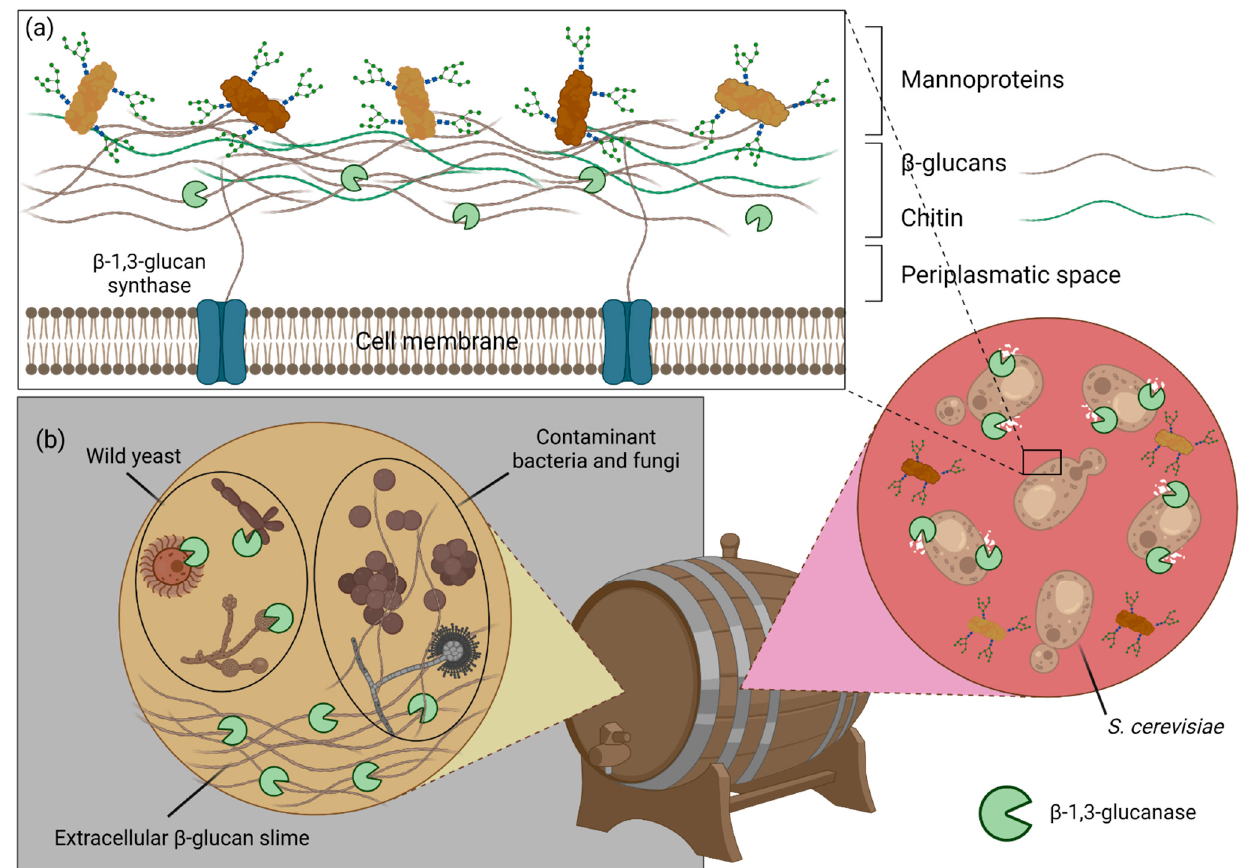
Figure 7. Applications of β -1,3-glucanases in the winemaking process. ( a ) The starter yeasts, usually S. cerevisiae , possess several components in their cell wall, most importantly mannoproteins that, when released into the wine, improve several organoleptic and technological properties of the final product. By hydrolyzing yeast cell wall β -glucans, β -1,3-glucanases promote the release of those mannoproteins. ( b ) Exogenous β -1,3-glucanases also contribute to improved wine quality and longevity by promoting the lysis of contaminant wild yeast, which are responsible for several off-flavors, and by hydrolyzing the extracellular β -glucan-rich slime produced by contaminant fungi and bacteria, which are the cause of the undesirable wine “ropiness”.